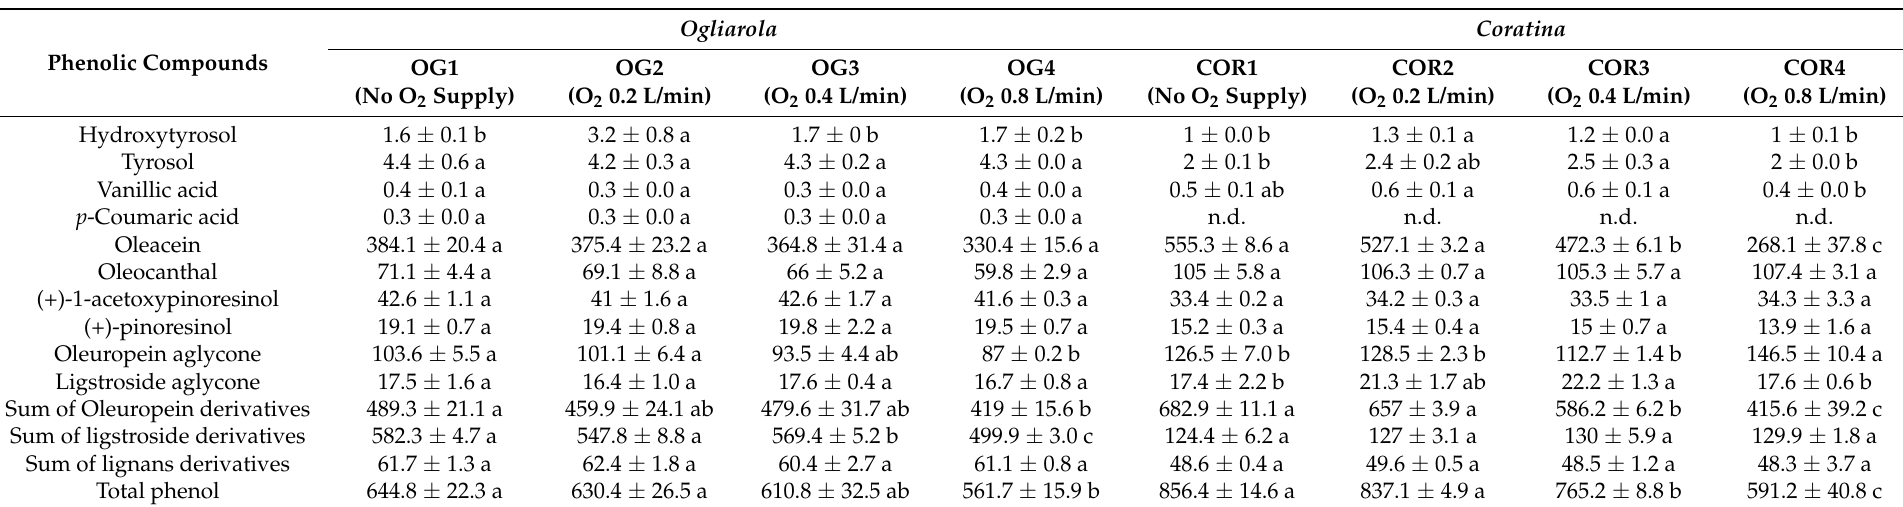
Table 2. Phenolic composition (mg/kg) of VOOs extracted with different values of oxygen flow during the crushing phase